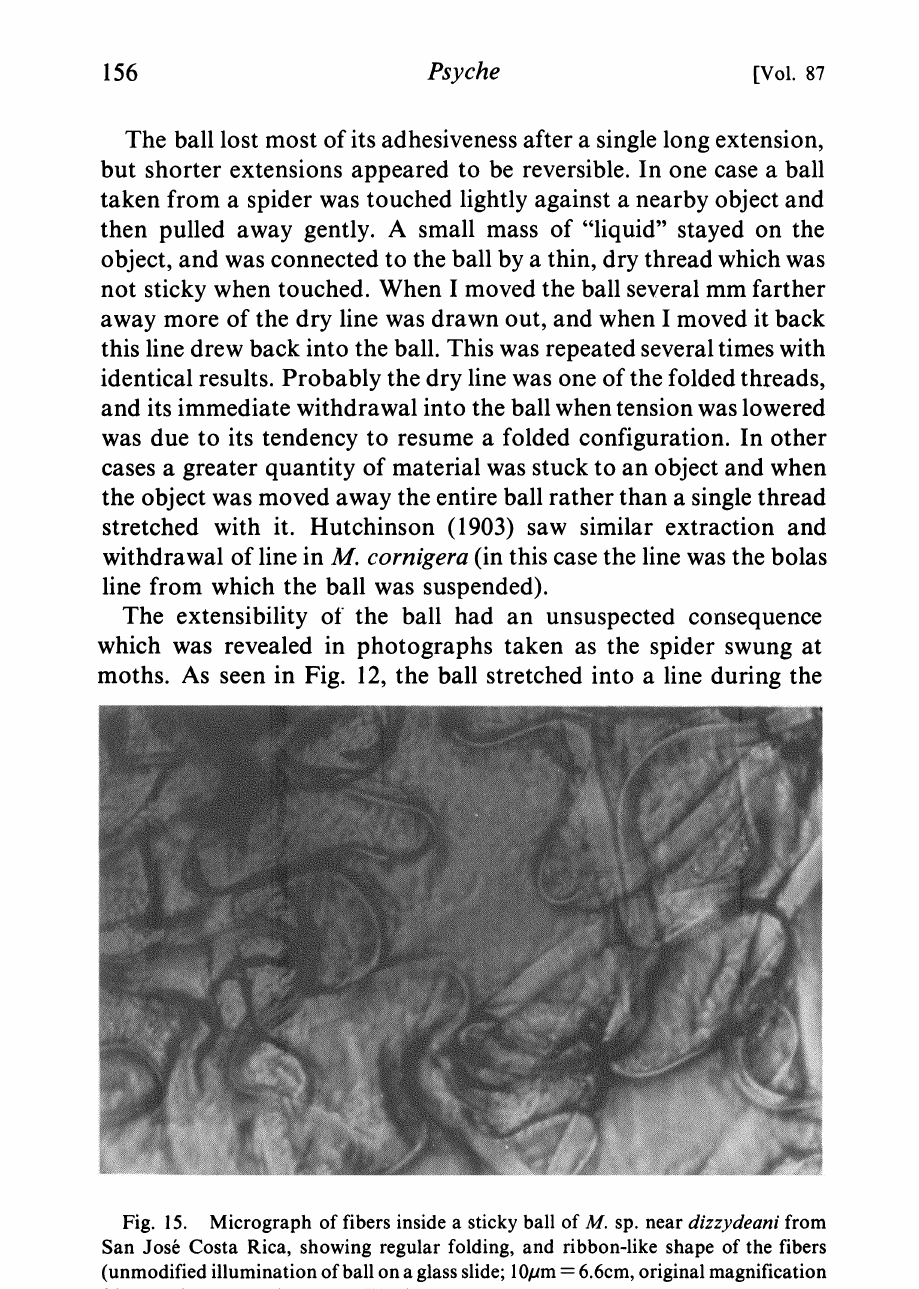
Fig. 15. Micrograph of fibers inside a sticky ball of M. sp. near dizzydeani from San Jos6 Costa Rica, showing regular folding, and ribbon-like shape of the fibers (unmodified illumination ofball on a glass slide; 10pm 6.6cm, original magnification 250X). Photograph by R. W.